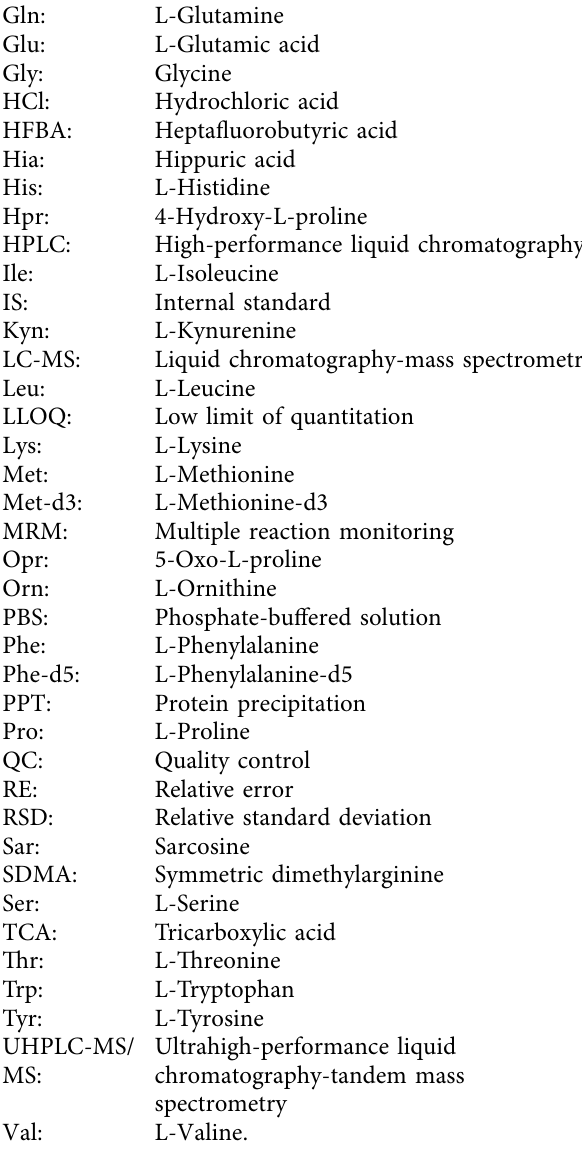
TABLE S1: the control substances of 34 amino acids and 3 ISs. TABLE S2: the extraction recovery and matrix effect of 34 amino acids and 3 ISs ( n = 6). TABLE S3: the intra- and interday accuracy and precision of 34 amino acids ( n = 5). TABLE S4: the stability results of 34 amino acids ( n = 3). TABLE S5: the dilution effect results of 34 amino acids ( n = 3). FIGURE S1: the representative total ion current chromatograms and MRM chromatograms of 34 amino acids and 3 ISs—(a) blank matrix; (b) blank matrix spiked with 34 amino acid and 3 ISs; (c) cancerous tissue